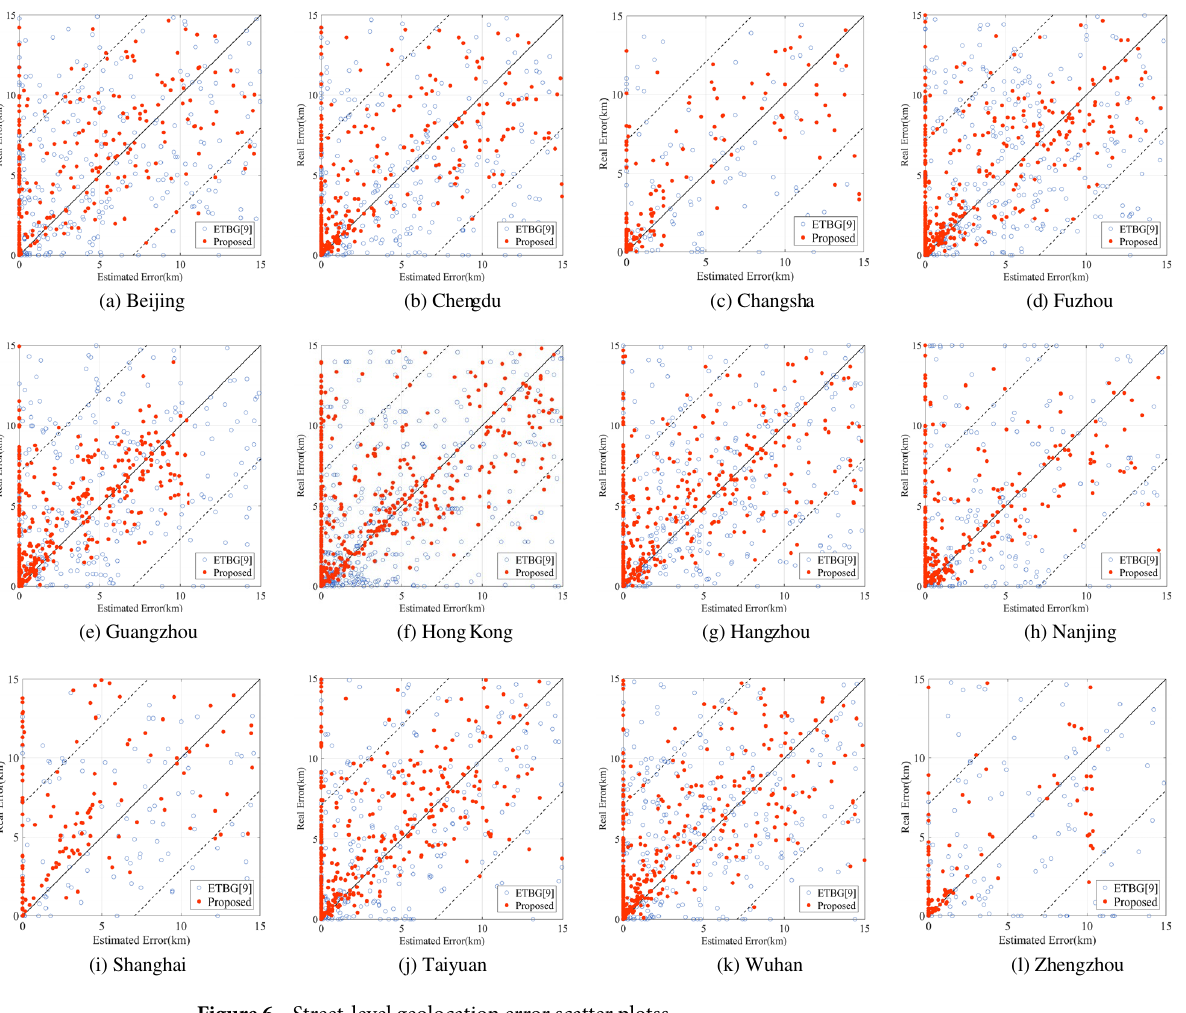
Figure 6. Street-level geolocation error scatter